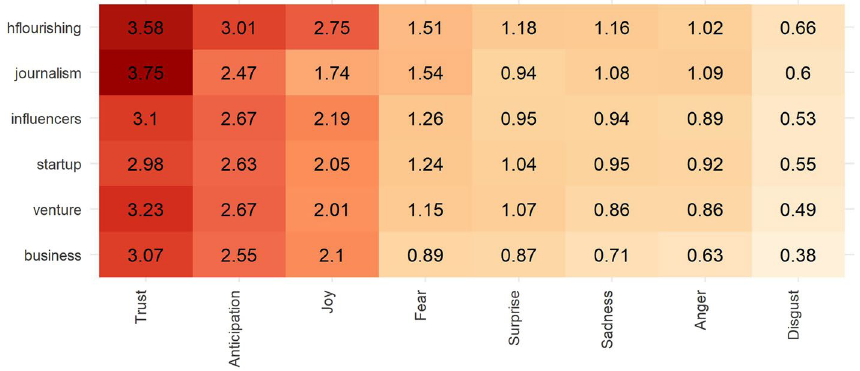
Figure 2. Scores for each of the emotions contained in the NRC lexicon for each selected list. All values were calculated after being normalized with respect to the total number of words in each sample. Graphs were made by the authors, using R programming.